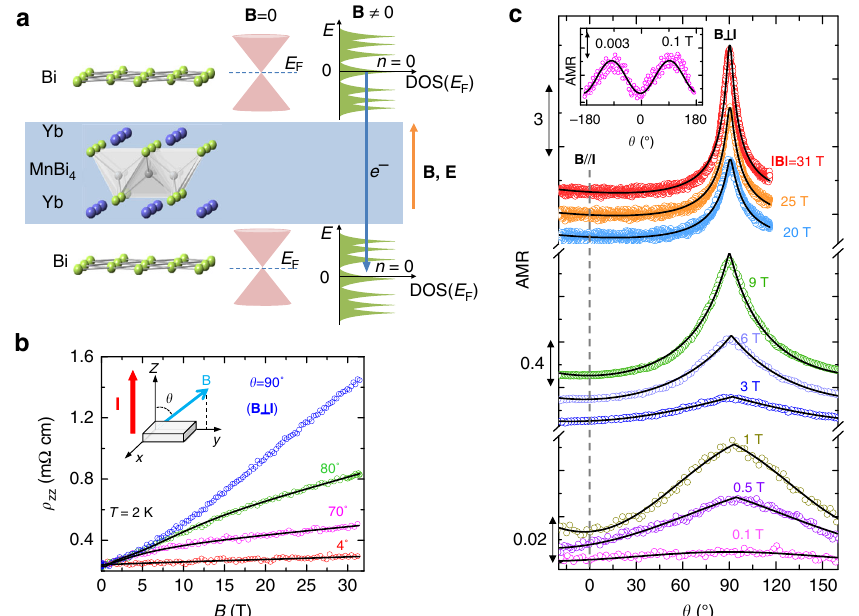
Fig. 2 Interlayer magnetotransport properties of YbMnBi 2 . a Schematic of the interlayer tunneling of the zeroth LLs ’ Weyl fermions. b The fi eld dependence of the out-of-plane resistivity, ρ zz ( B ), under different fi eld orientations at T = 2 K. The inset shows the experimental setup. The solid lines superimposed on the data represent the fi ts to Eq. (2) in the text. The fi t for θ = 90° is not available since the zeroth LLs disappear for in-plane fi eld. c Angular dependence of magnetoresistance (AMR), measured under different fi elds up to 31 T and at T = 2 K. The black curves superimposed on the data represent the fi ts to Eq. (2) in the text. At low fi elds (e.g., 0.1 T), AMR shows the sin 2 θ dependence expected for the Lorentz effect as shown in the inset , indicating that the interlayer transport at low fi elds is dominated by the Dirac band transport as discussed in the